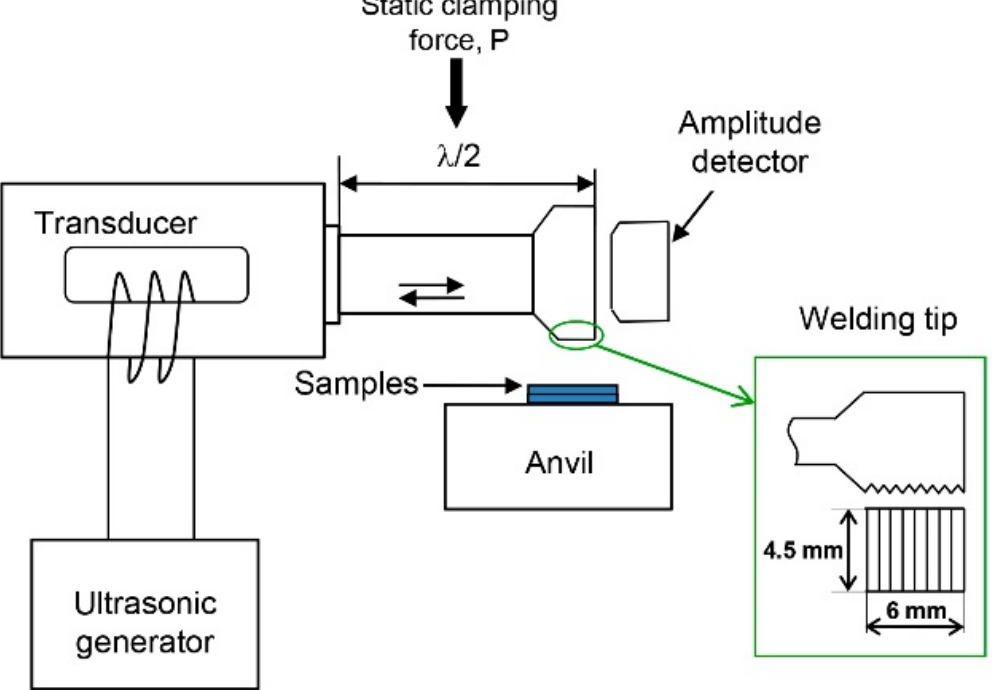
Figure 1. Schematic diagram of the ultrasonic spot welding. The static clamping force P is applied to the middle of the half-wave ( λ /2) welding instrument, i.e., at the displacement node.